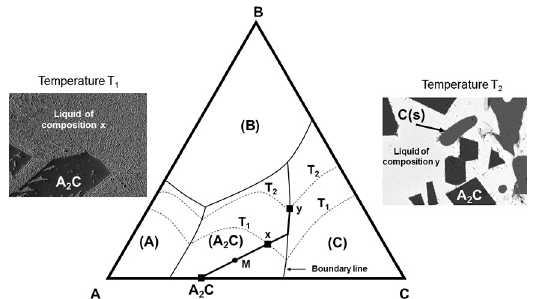
Figure 1. Schematic ternary phase diagram illustrating the use of the equilibration